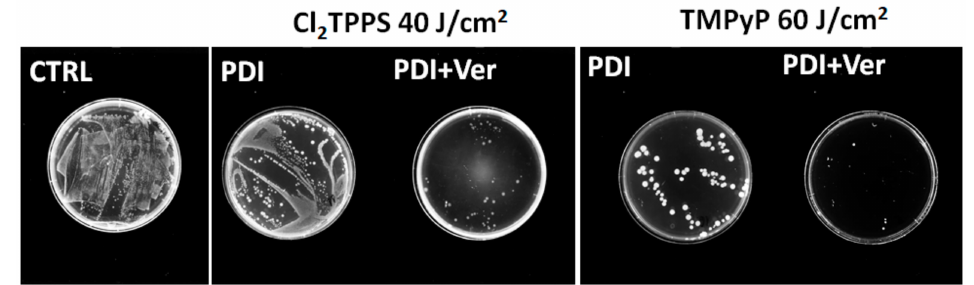
Figure 17. The e ff ect of the EPI on high-dose PDI. The colonies of E. coli grew on agar plates after PDI mediated by a Cl 2 TPPS of 40 J / cm 2 and TMPyP of 60 J / cm 2 , with and without verapamil addition.